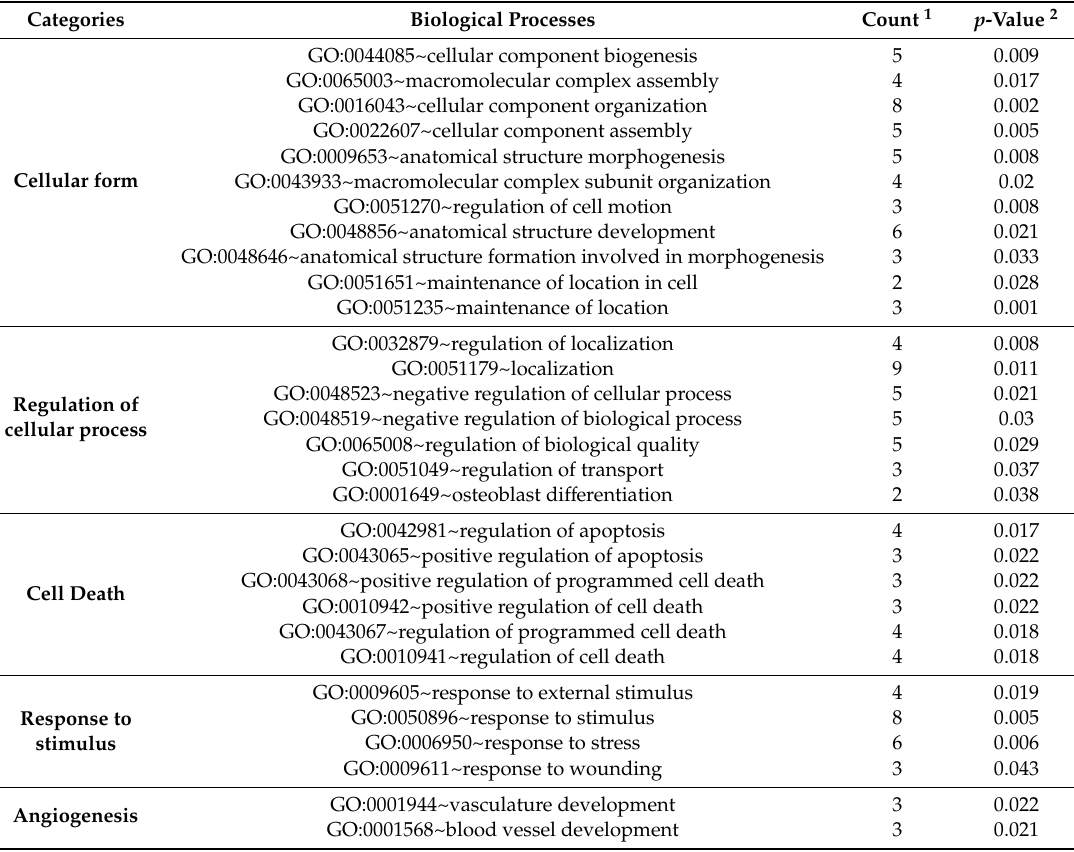
Table 3. Gene Ontology (GO) terms over-represented in significantly abundant whey proteins due to S. aureus